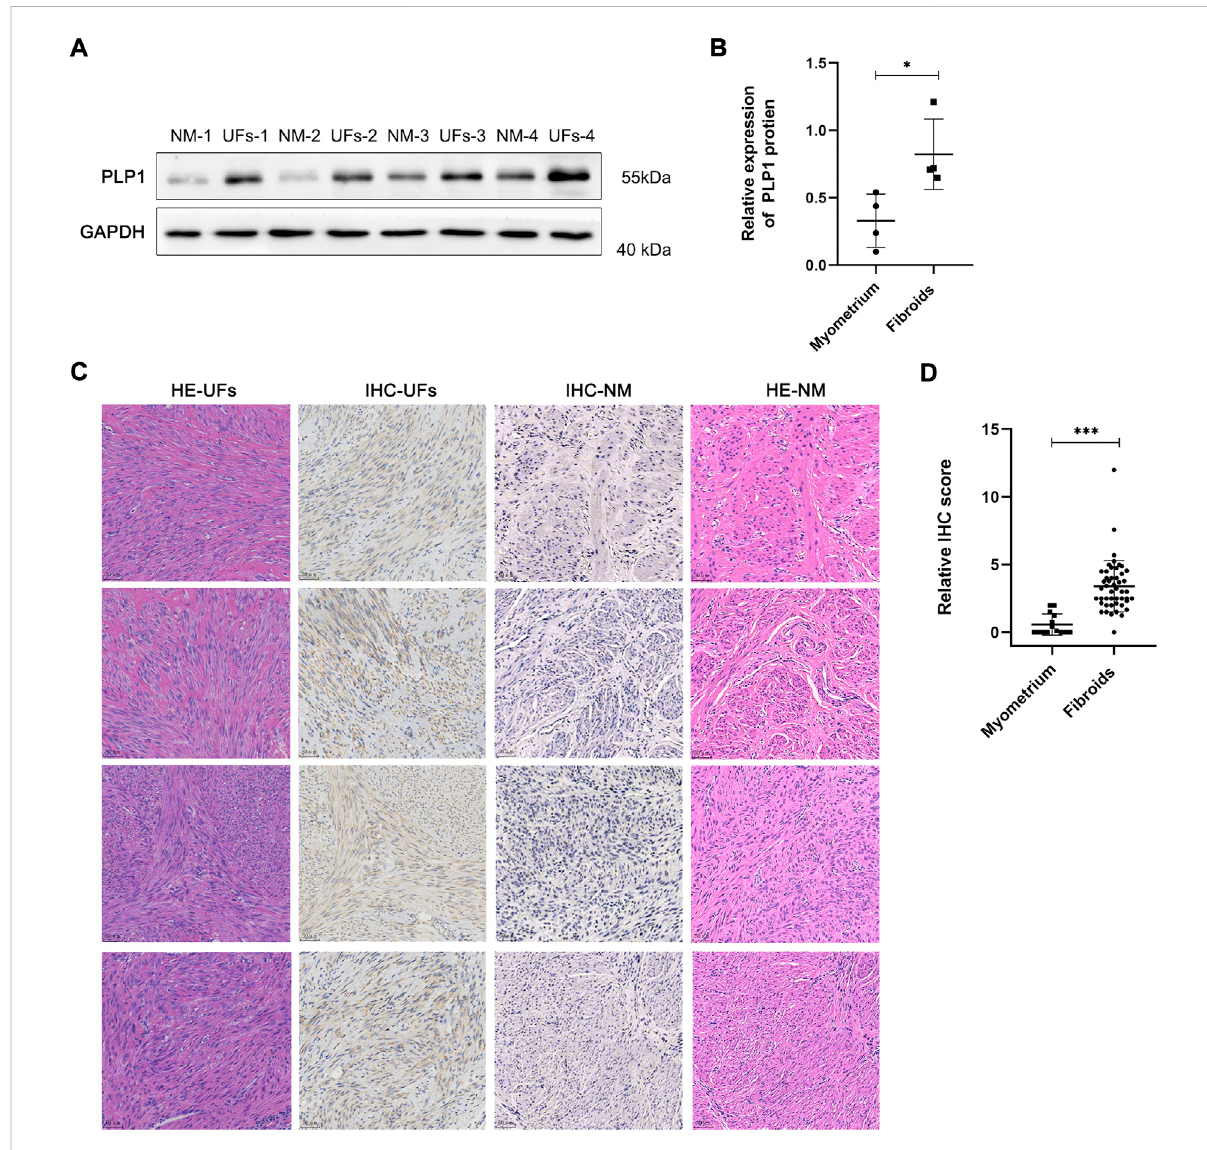
FIGURE 3 PLP1expression inUFstissue (A) ThePLP1proteinexpressionoftissuefrom fi broidsandnormal myometrium wasassessedbyWesternblot. (B) The relative expression of PLP1 is based on the gray value of Western blot. N = 4/groups. * p < 0.05. (C) Immunohistochemical and corresponding hematoxylin and eosin stains results of fi broids and normal myometrium tissue (magni fi cation 200). IHC, immunohistochemical, HE, hematoxylin and eosin stains, UFs, Uterine Fibroids, NM, Normal Myometrium. (D) Relative IHC score. UFs, n = 48. NM, n = 14. *** p <